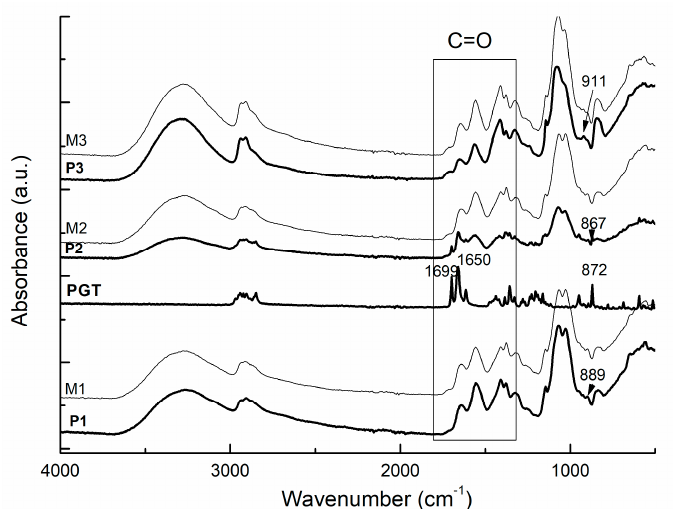
Figure 2. FT˙IR spectra of the studied formulations and pure progesterone. P1: CS-g-PNIPAAm/PVA 80/20 +PGT; M1: CS-g-PNIPAAm/PVA 80/20 ; P2: CS-g-PNIPAAm/PVA 95/5 +PGT; M2: CS-g- PNIPAAm/PVA 95/5 ; P3: CS-g-PNIPAAm/PVA 75/25 +PGT; M3: CS-g-PNIPAAm/PVA 75/25 .